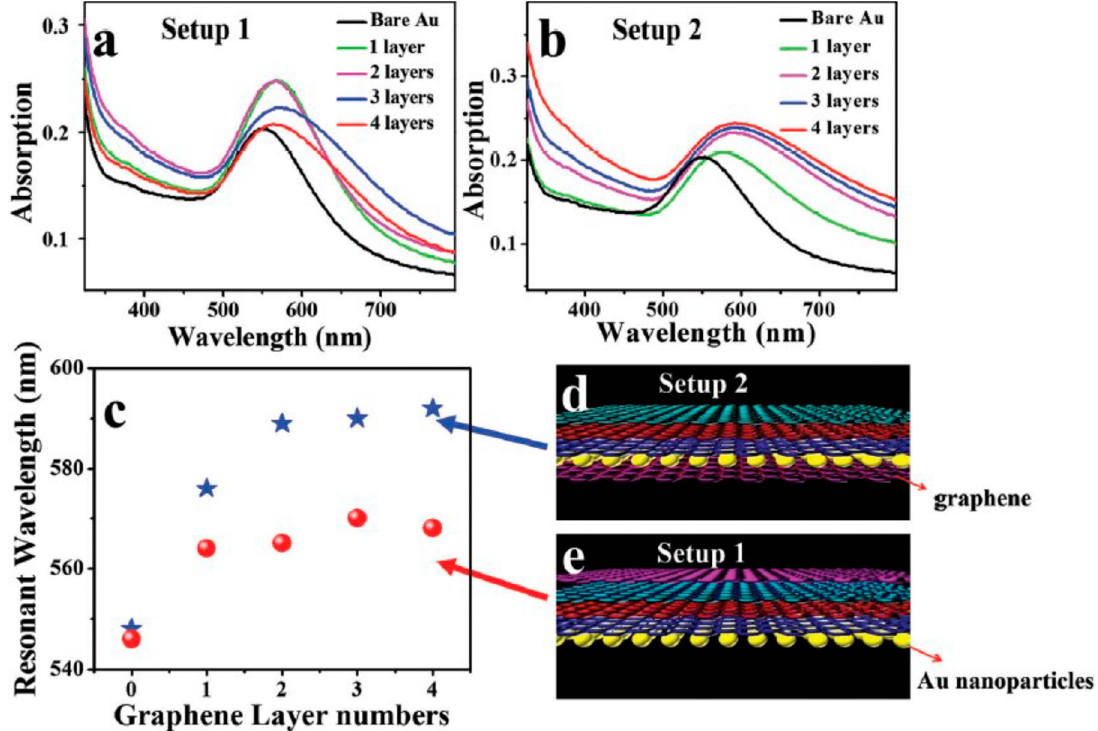
Figure 3. Absorption spectra of gold NPs coated ( a ) and encapsulated ( b ) by graphene layers. ( c ) Gold NP LSPR wavelengths for Setups 1 and 2. ( d , e ) The structures of the setups used in (b,a) [67].